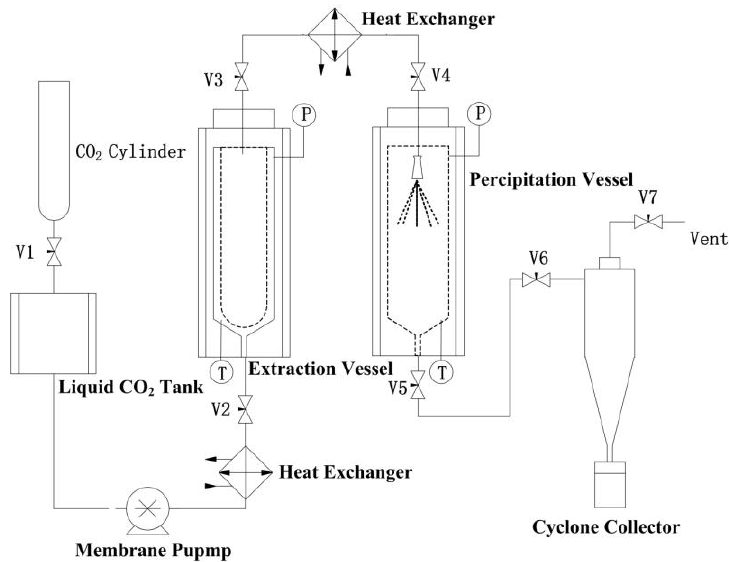
Figure 8. Schematic diagram of the rapid expansion of supercritical solutions (RESS) apparatus.